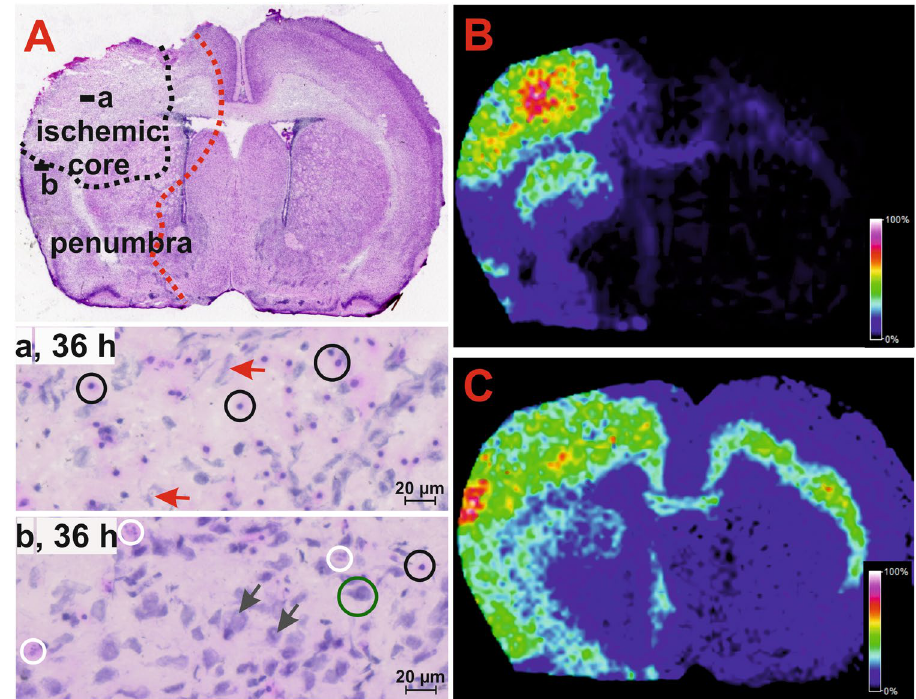
Figure 3. Subacute response to HI insult in the neonatal rat brain. (A) Haematoxylin-eosin stained section showing the ischaemic core of the lesion containing large-bodied astrocytes with an eosinophilic cytoplasm (cells indicated by black circles in the both expanded areas) and necrotic neuronal debris (red arrows, panel a); penumbra area (panel b) showing necrotic (white circles) and shapeless (black arrows) cells and intact neurons (green circle). MALDI MS images showing the altered distribution of NAPE (54:4) and GM2 (d18:1/18:0) in the affected area detected as deprotonated molecules at m/z 1004.768 ( B ) and 1382.805 ( C ),